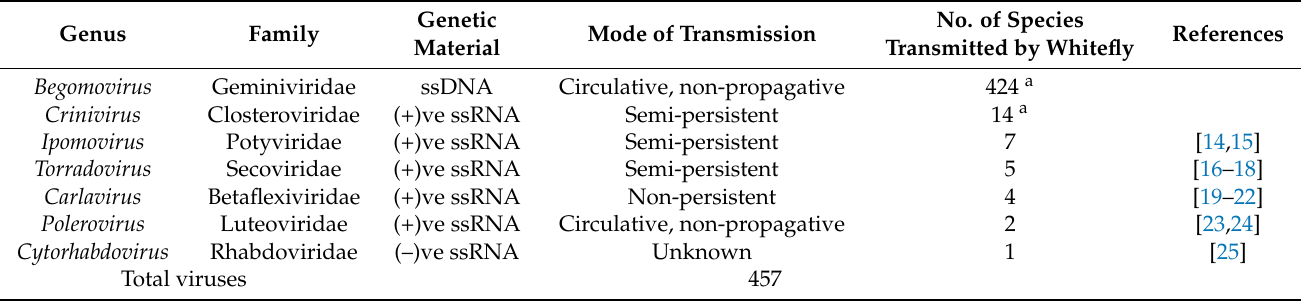
Table 1. List of the genera of viruses transmitted by